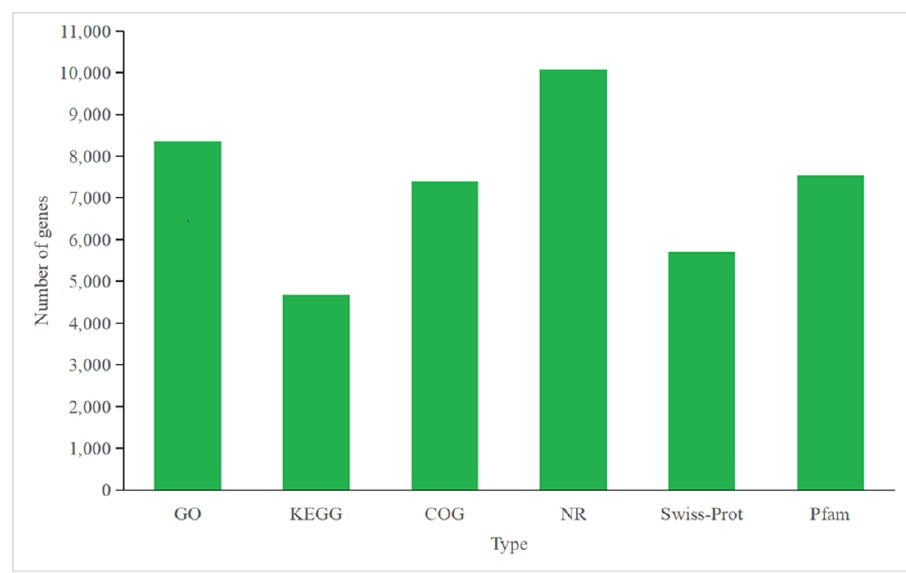
Figure 5. Functional annotation of unigenes in P. tricornutum .